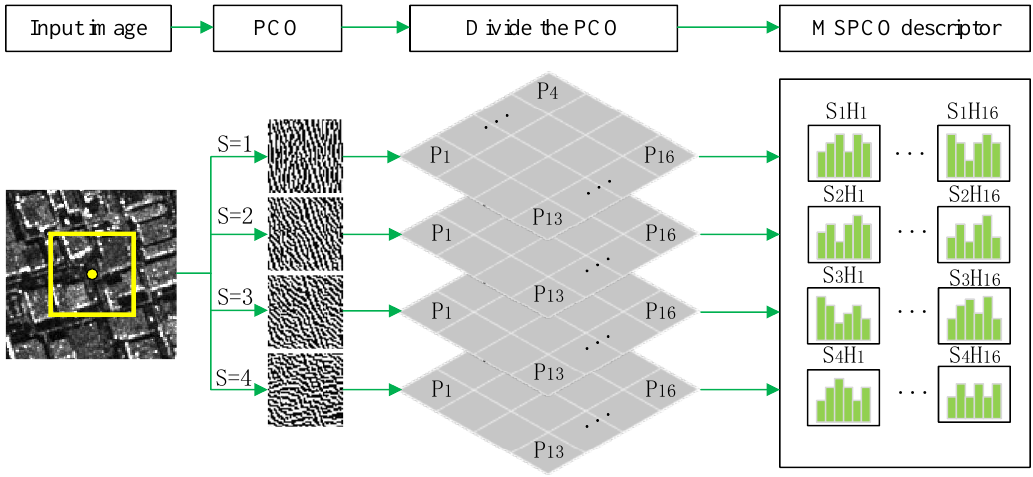
Figure 5. Illustrative example of the PCO calculation.